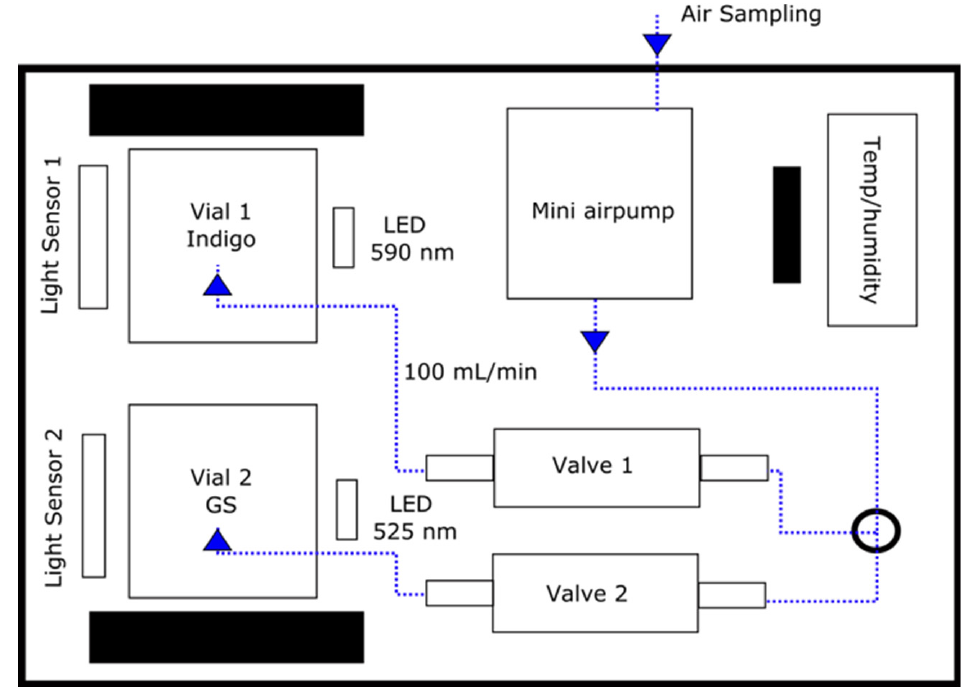
Figure 1. The analytical platform schematically represented.